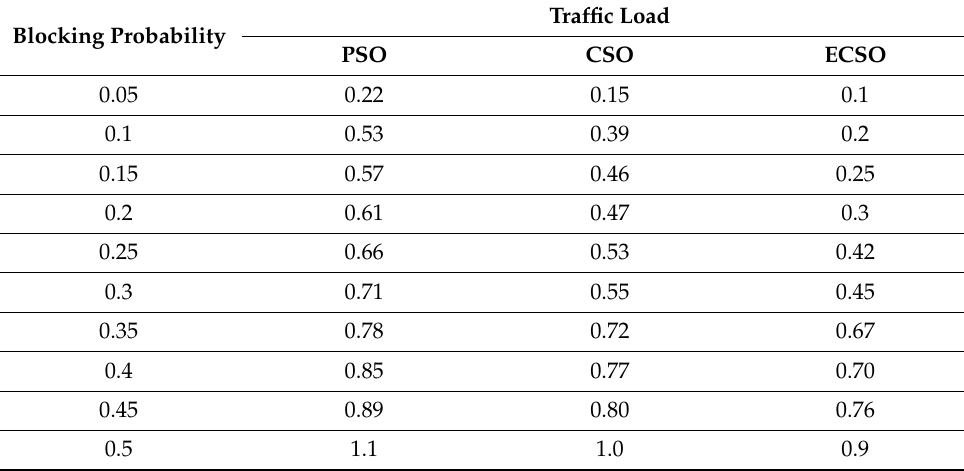
Table 2. Blocking probability versus traffic load.